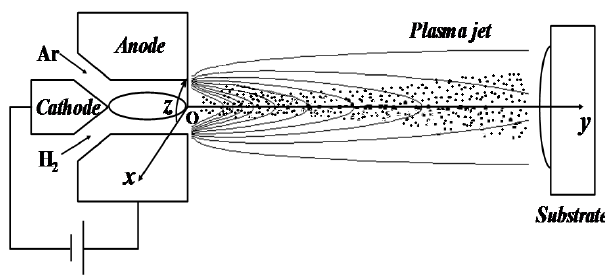
Figure 2. The schematic of suspension plasma spray with axially injected droplets or particles.